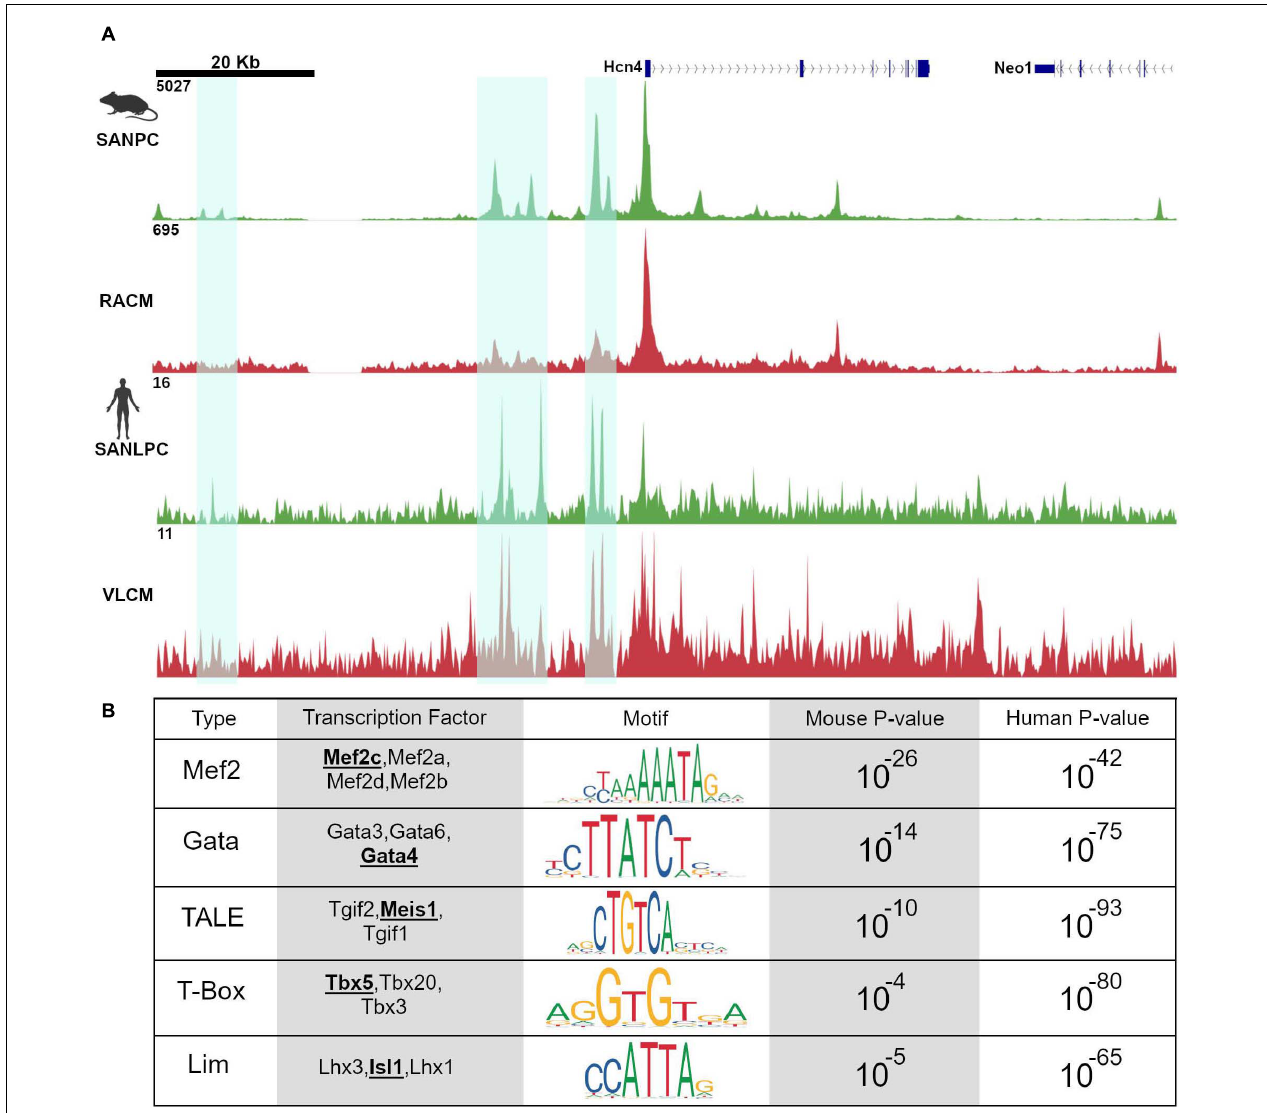
FIGURE 3 | Pacemaker cell-specific chromatin accessibility profiles are deeply conserved. (A) Alignment of ATAC-seq data at the Hcn4 genomic locus from mouse neonatal pacemaker cells with human induced pacemaker-like cells demonstrate regions of open chromatin that are present in both species, highlighted in cyan. (B) Motif enrichment analysis of differentially accessible regions between SAN and non-SAN myocytes demonstrated that enrichment of similar transcription factor motifs are present in mouse and human pacemaker cells, suggesting a conserved mammalian pacemaker cell transcriptional program. SANLPC, sinoatrial node pacemaker cells; RACM, right atrial cardiomyocytes; SANLPC, sinoatrial node-like pacemaker cells; VLCM, ventricular-like cardiomyocytes.